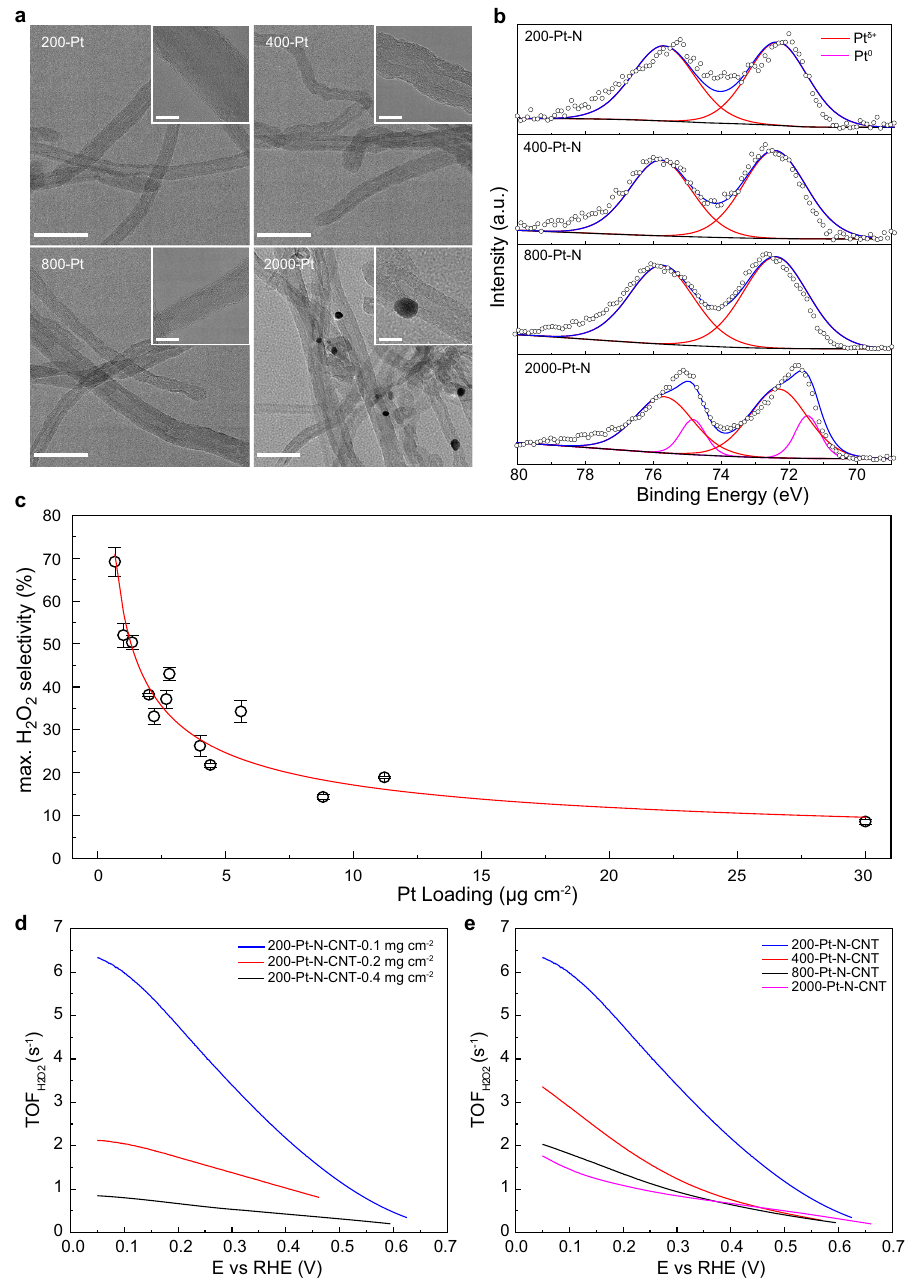
Fig. 5 Pt loading effect on H 2 O 2 selectivity. a TEM images of 200-, 400-, 800- and 2000-Pt-N-CNT. Scale bars, 50 nm. Inserts are the zoom-in view of certain carbon nanotubes at a fi xed scale bar of 10 nm. b Core-level XPS spectra for Pt 4 f region. c The maximum H 2 O 2 selectivity as a function of Pt loading. The rightmost data point was measured on commercial TKK 30 wt.% Pt/C catalyst and plotted with actual Pt weight loading, while all other data on Pt-N-CNT were plotted using determined Pt content from XPS measurements. d Calculated TOFs of 200-Pt-N-CNT with different catalyst loading, and e calculated TOFs of n -Pt-N-CNT with different Pt site density but a fi xed catalyst loading of 0.1 mg cm − 2